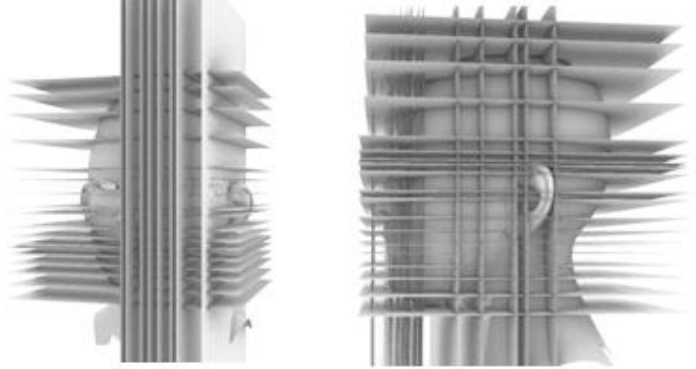
Figure 6. Plane location according to feature points.